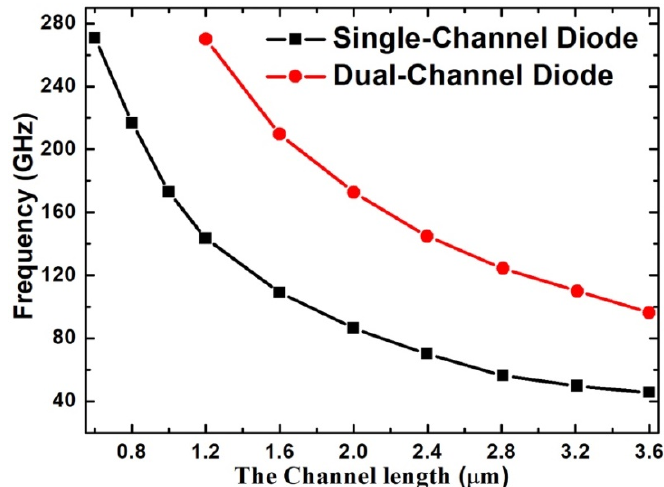
Figure 2. Variation of frequency f with the channel length L in the grooved-anode diode and single-channel diode.